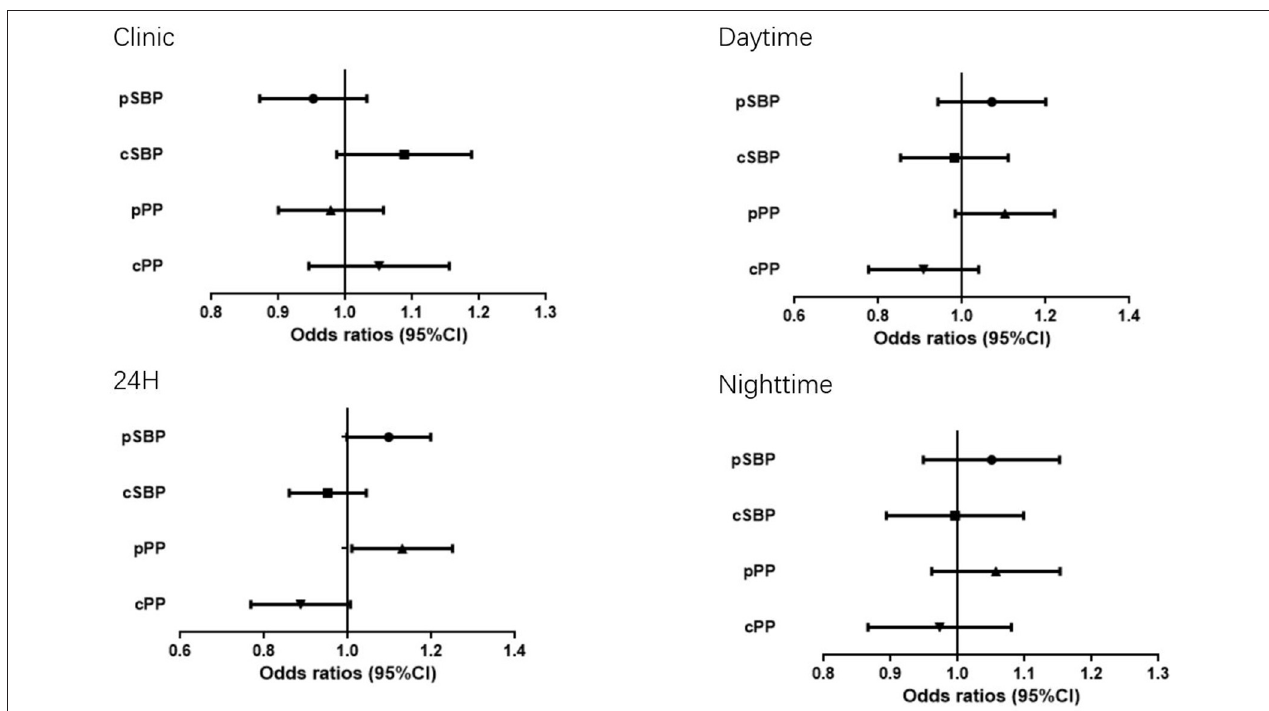
FIGURE 1 | Odds ratio (OR) and 95% Confidence Interval (CI) of Hypertension-mediated organ damage with the all BP measurements.